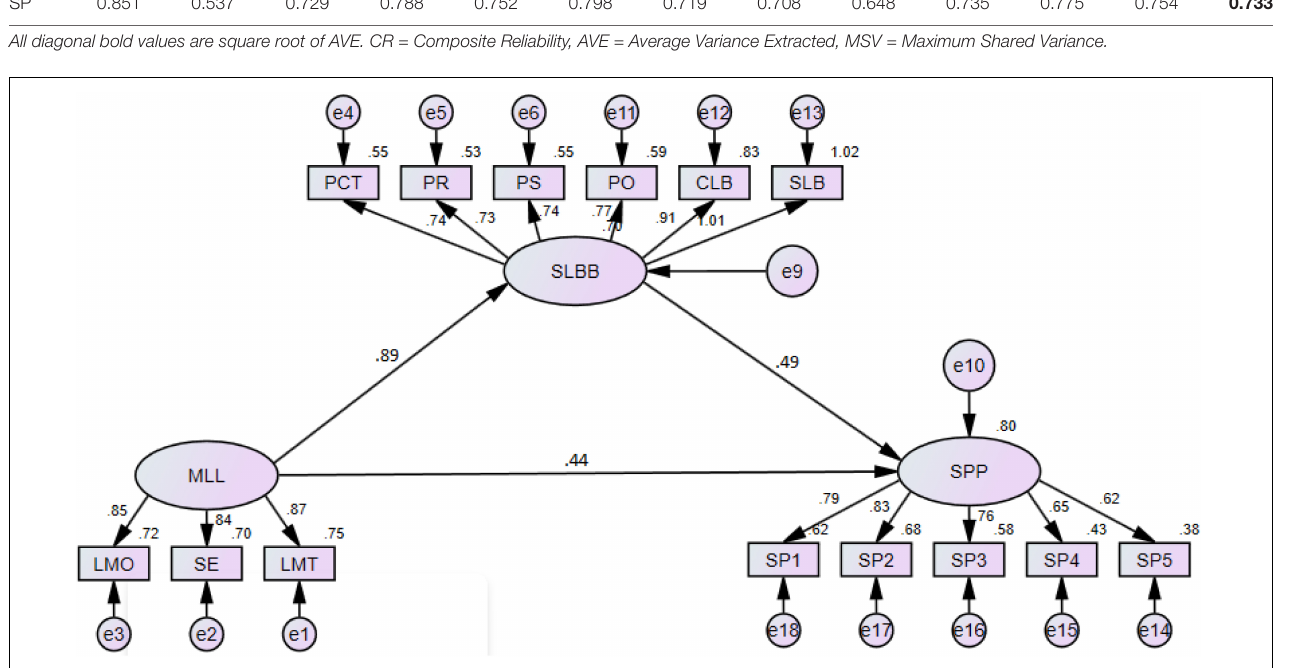
FIGURE 4 | Path analysis.